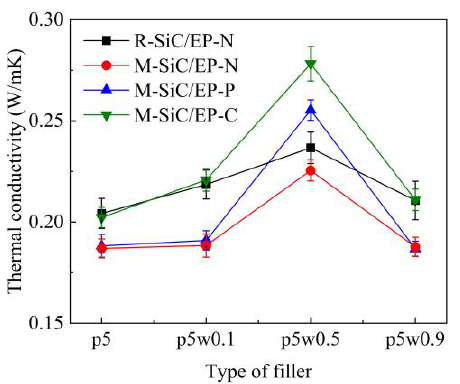
Figure 12. Comparison of thermal conductivity of four kinds of SiC/EP composites.